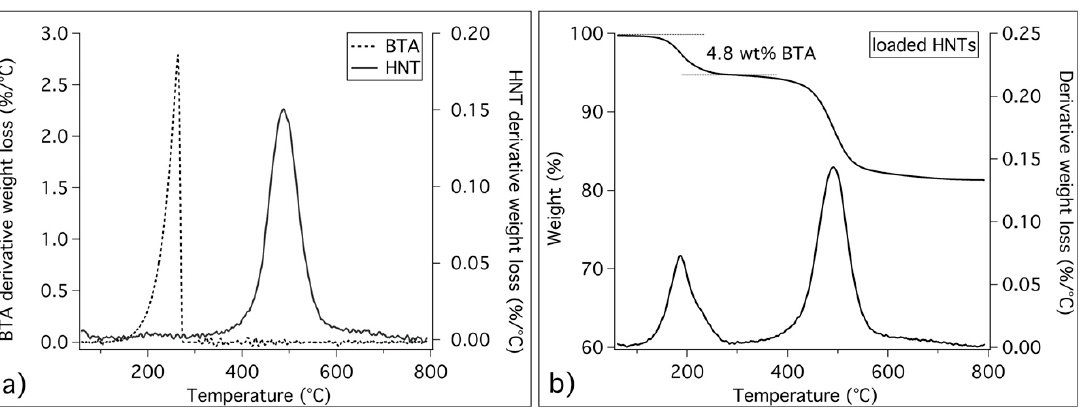
Figure 2. Thermogravimetric curves: ( a ) derivative thermogravimetry (DTG) curves of pristine benzotriazole (BTA) and halloysite nanotubes (HNTs); ( b ) thermogravimetry (TG) / DTG curves of loaded HNTs, together with the evaluation of BTA weight amount in loaded nanotubes .